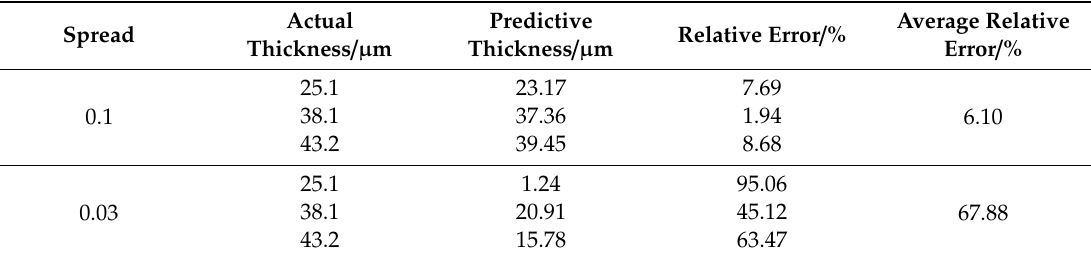
Table 5. Output results of the RBF neural